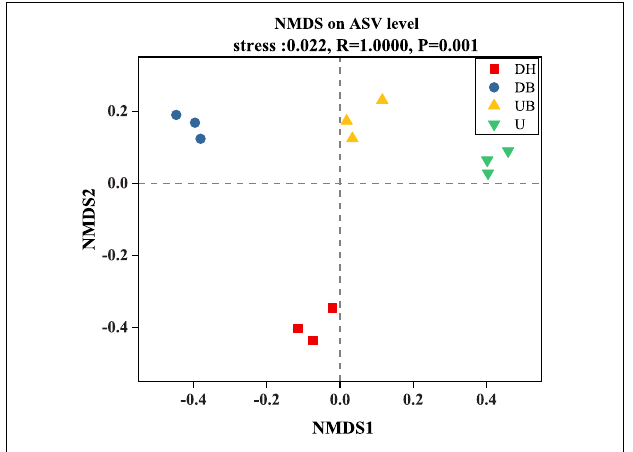
FIGURE 4 | Non-metric multidimensional scaling of bacteria community structure between biocrusts at different disturbance levels.